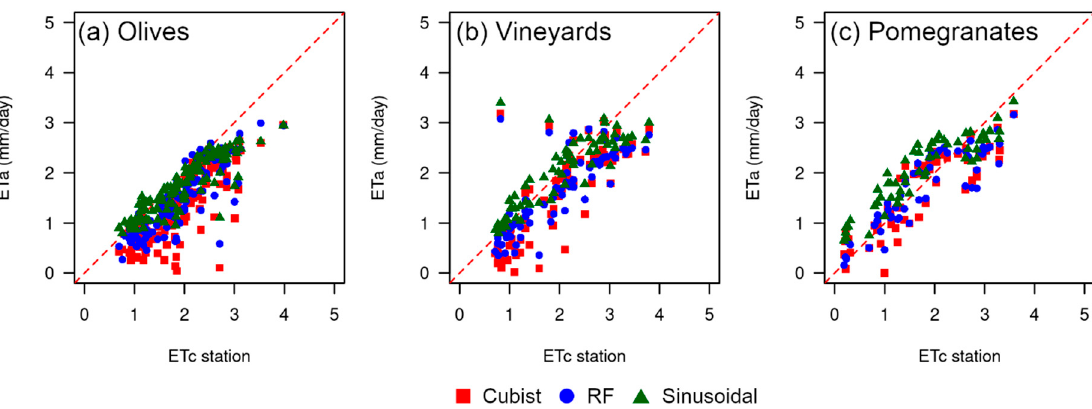
Figure 10. Predicted ETa at the 10 m resolution of the cubist, random forest, and sinusoidal model compared to the ETc station in ( a ) olives, ( b ) vineyards, and ( c ) pomegranates.